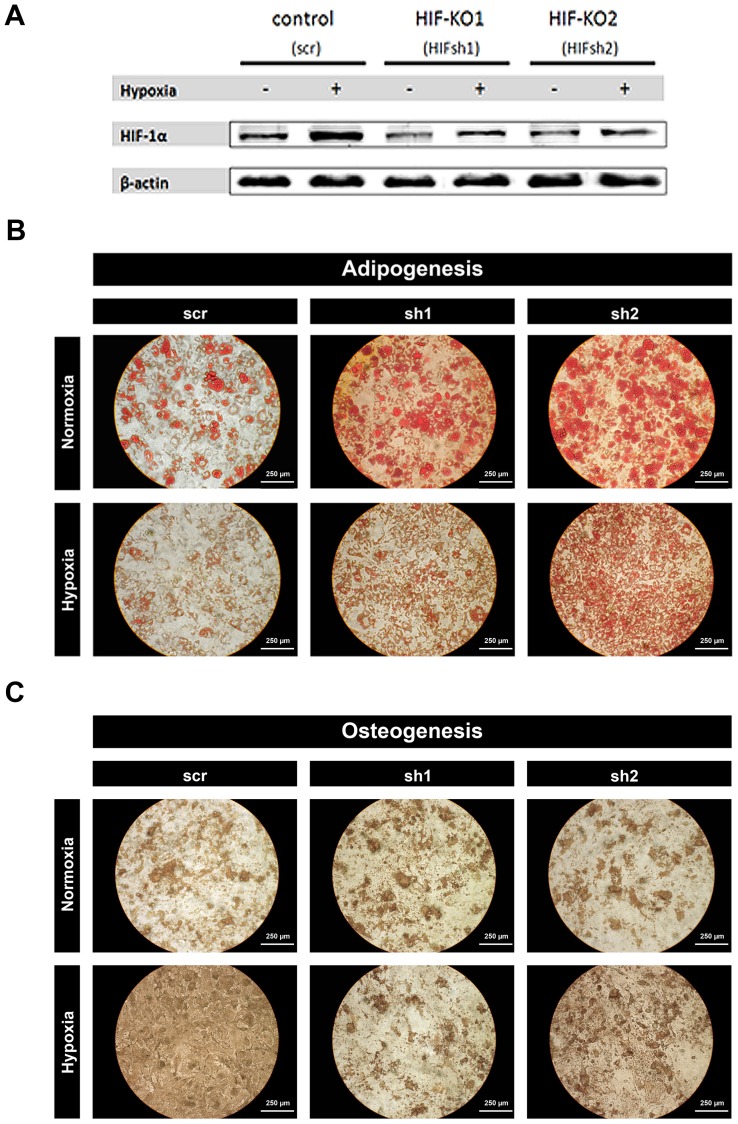
Reduction of HIF-1α of human MSCs (i) enhances adipogenesis under normoxic conditions, (ii) partially restores hypoxia-induced attenuation of adipogenesis and (iii) suppresses hypoxia-enhanced osteogenesis.(a) Transduction of anti HIF-1α-shRNA-constructs efficiently reduced HIF-1α protein expression as shown by immunoblot (2-weeks data). (b) Oil-Red-O stain for the analysis of adipogenesis of shRNA-construct transduced MSCs and (c) von-Kossa stain for the analysis of osteogenesis of shRNA-construct transduced MSCs. Cells were maintained under normoxia (≈18% pO2) or hypoxia (1% pO2) for 4 weeks using either osteogenic or adipogenic differentiation medium (scale indicated on the figure; n = 3).